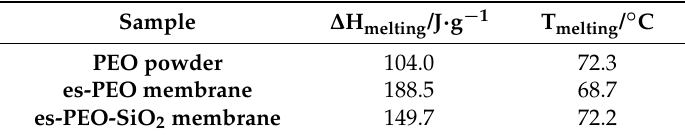
Table 1. Enthalpy change and temperature related to PEO melting (values derived from DSC response in Figure 3).